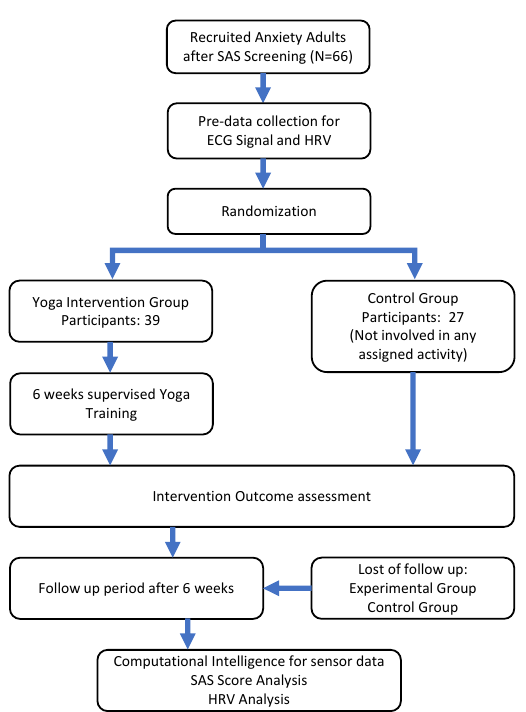
Figure 1. The workflow of the study to detect, estimate and reduce anxiety using yoga, IIoMT, and machine learning.